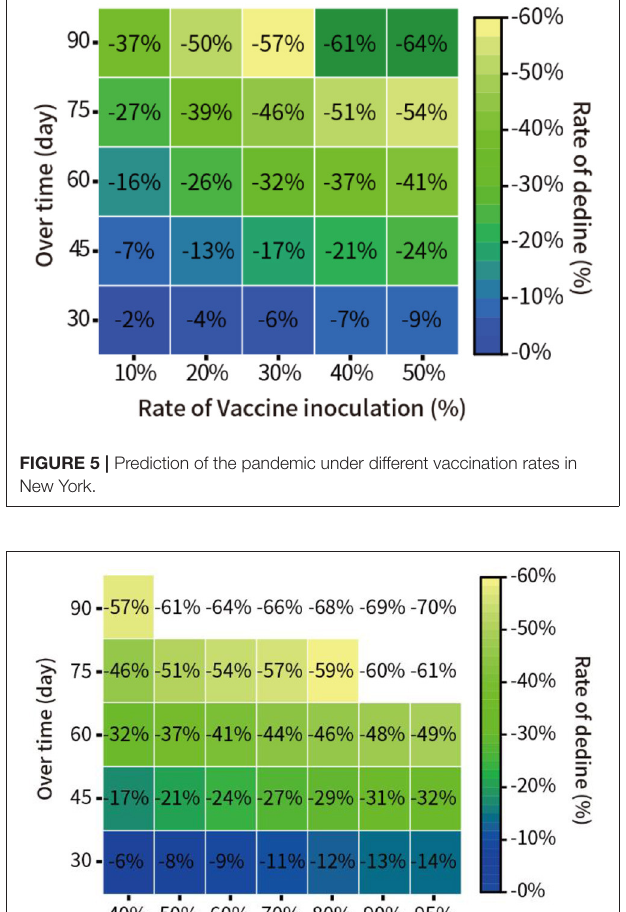
70, 80, and 95%. We quantitatively predicted the decline in the proportion of infections at 30, 45, 60, 75, and 90 days from 16 December 2020. The results are shown in Figure 6